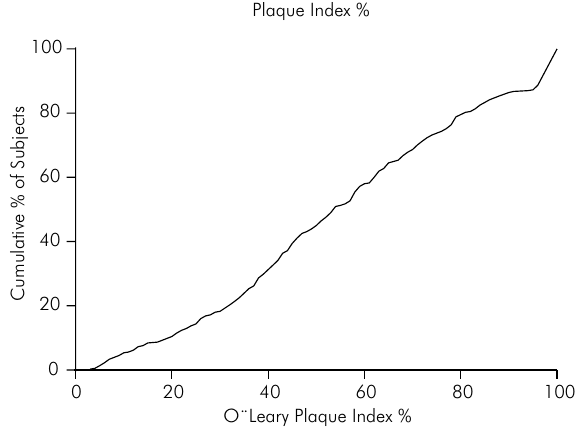
Figure 2. Cumulative percent of individuals according to the plaque index.